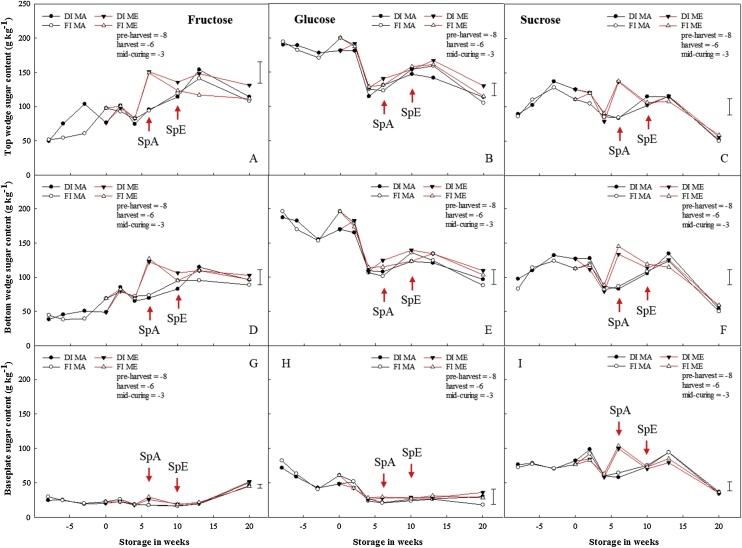
Pre- and postharvest sugar content in stored onion bulbs treated with and without 1-MCP and ethylene. Fructose, glucose and sucrose contents per dry weight for the top wedge (A, B and C), bottom wedge (D, E and F) and baseplate (G, H and I) of onion bulbs of cultivar ‘Sherpa’ grown in 2016 under full irrigation (FI) or deficit irrigation (DI); where FI amounted to 100% replenishment of crop evapotranspiration (ETc) and DI was ETc replenishment at 50%. Bulbs were harvested at full maturity (100% fall-down) and cured under glass for six weeks for both years. After curing, bulbs were treated with 1-MCP at 1 μL L−1 for 24 h before storage and were stored at 1 °C under continuous ethylene supplementation at 10 μL L-1 or air. DIMA and FIMA are DI and FI bulbs treated with 1-MCP and stored in air and DIME and FIME are DI and FI bulbs treated with 1-MCP and stored under ethylene. SpA and SpE are sprout emergences for bulbs stored in air and ethylene, respectively. LSD bar at 95% confidence shown.